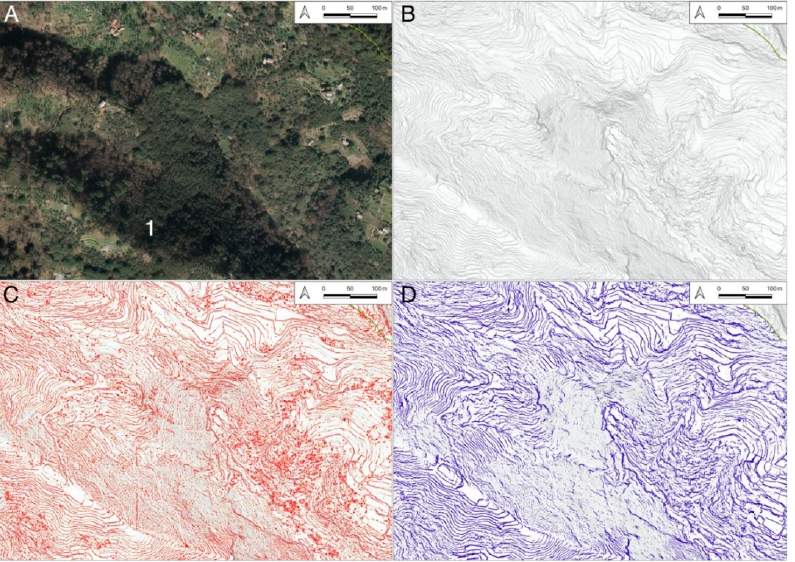
Figure 8. Comparison of the detailed areas in the box: Figure 1: ( A ) orthophotography; ( B ) SKF; ( C ) LUC; ( D ) LIHA.